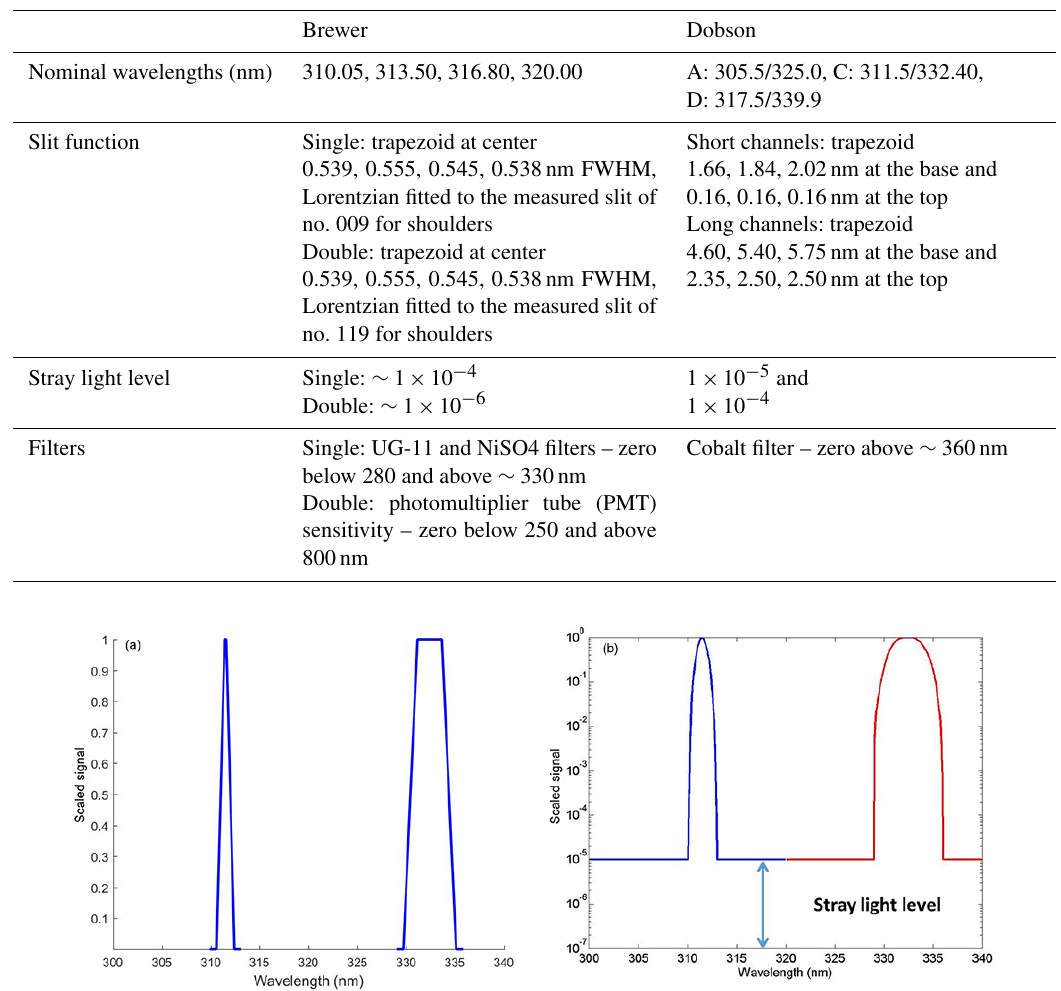
Figure 3. Dobson C-pair ideal slit functions (a) parameterized from Fig. 1 of Komhyr. (1993). Dobson modeled slit functions (b) . Two straight lines have been added to the core slit functions in order to account for stray